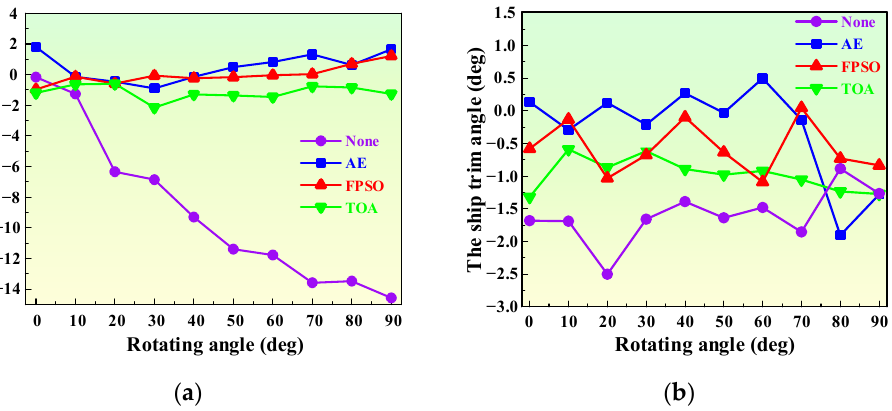
Figure 17. Variation curves of ship trim and heel angles with different algorithms. ( a ) The ship heel angle. ( b ) The ship trim angle.